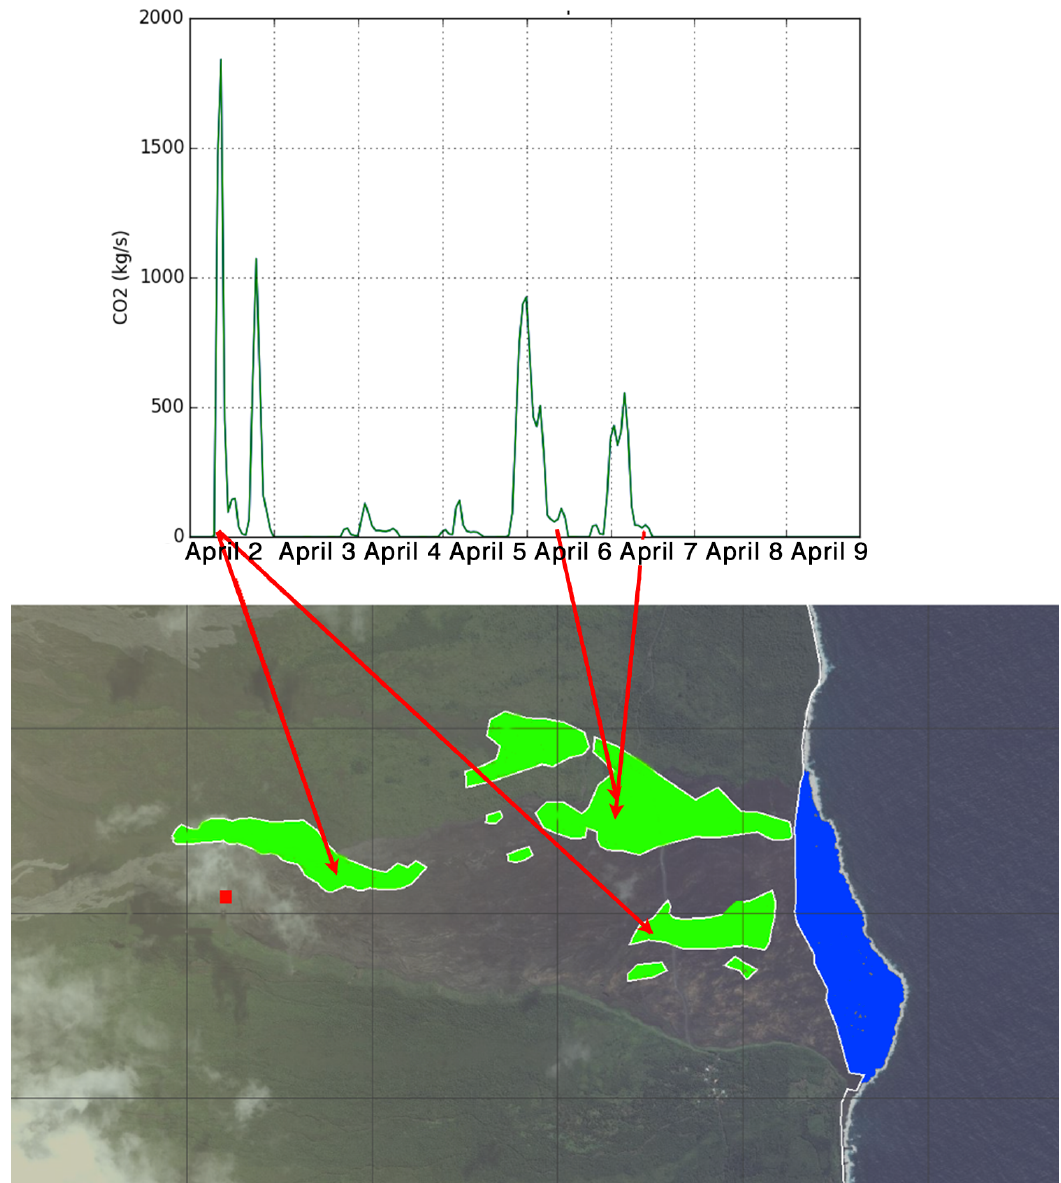
Figure 3. Above : Emission of CO 2 from burning forests, emitted by the ForeFire surface model towards atmospheric model. Bottom : Correspondence of CO 2 emission peaks with forest areas in green. (In blue, new land created by the lava flow and area of water vapor and HCl